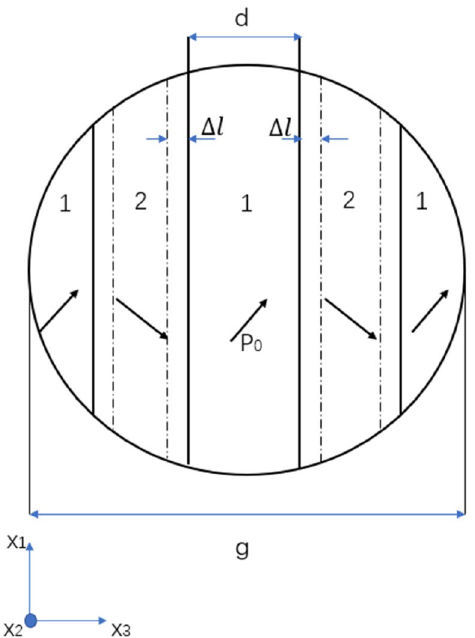
Figure 2. Schematic illustration of a spherical nanoparticle (simplified as a crystallite) with a laminar 90° domain structure with spontaneous polarisation P 0 and domain size d , recreated from 48